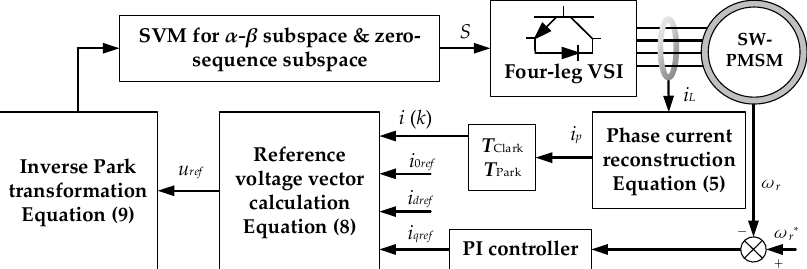
Figure 8. Block diagram of proposed DBPCC for the TPSW-PMSM drive.